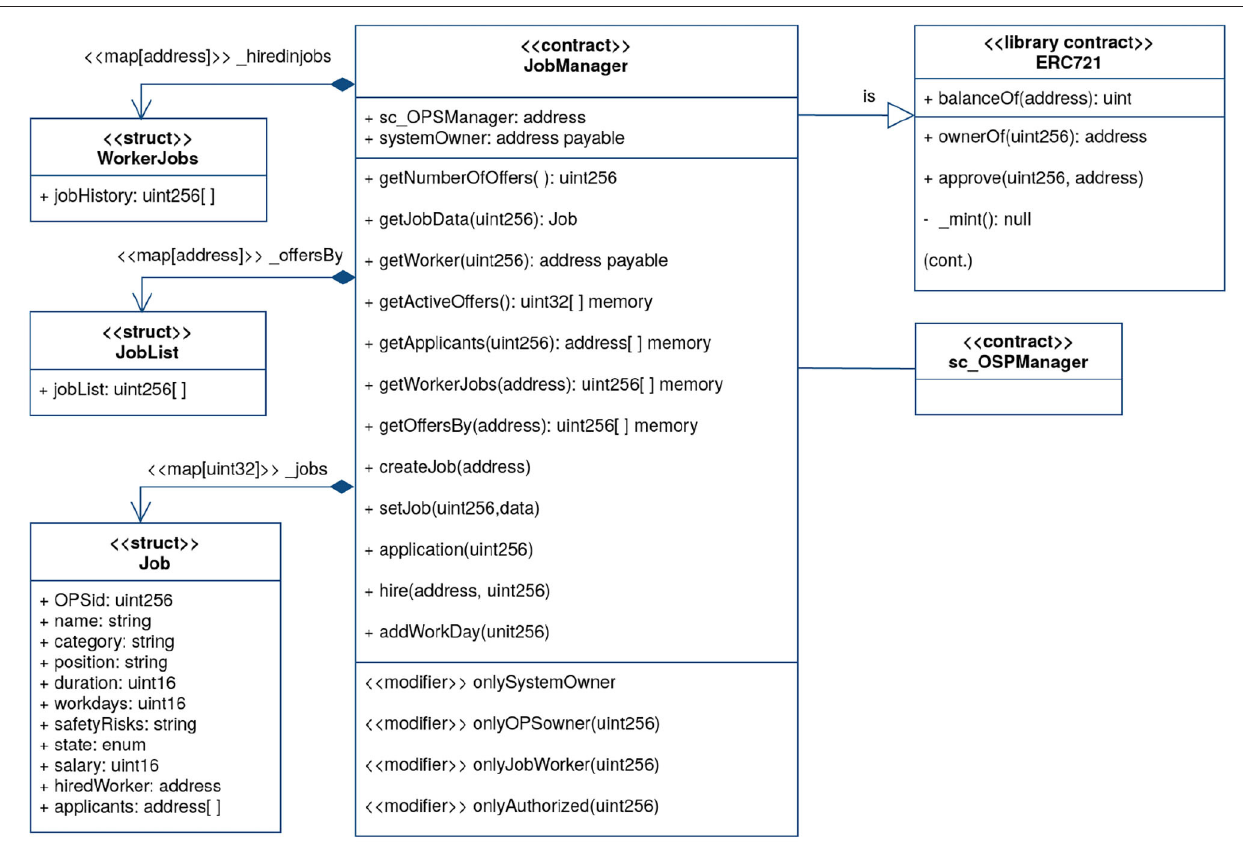
FIGURE 7 | The contract diagram of the smart contract